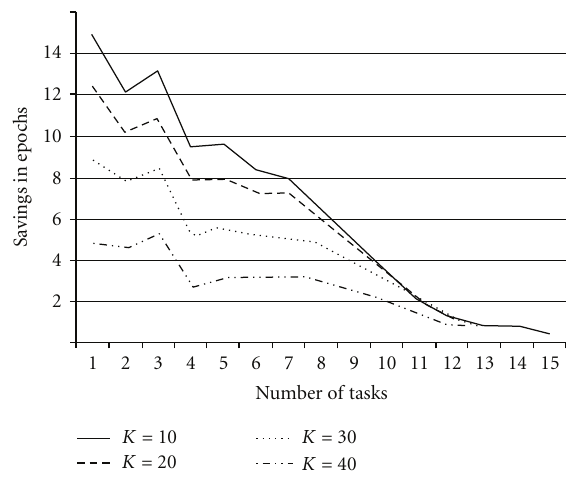
Figure 7: Savings in successive